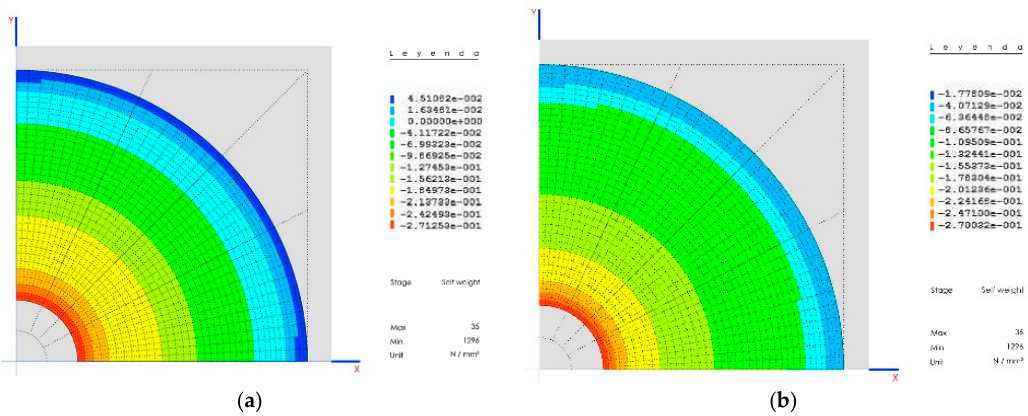
Figure 6. ( a ) Parallel stress; ( b ) the whole dome working in compression.